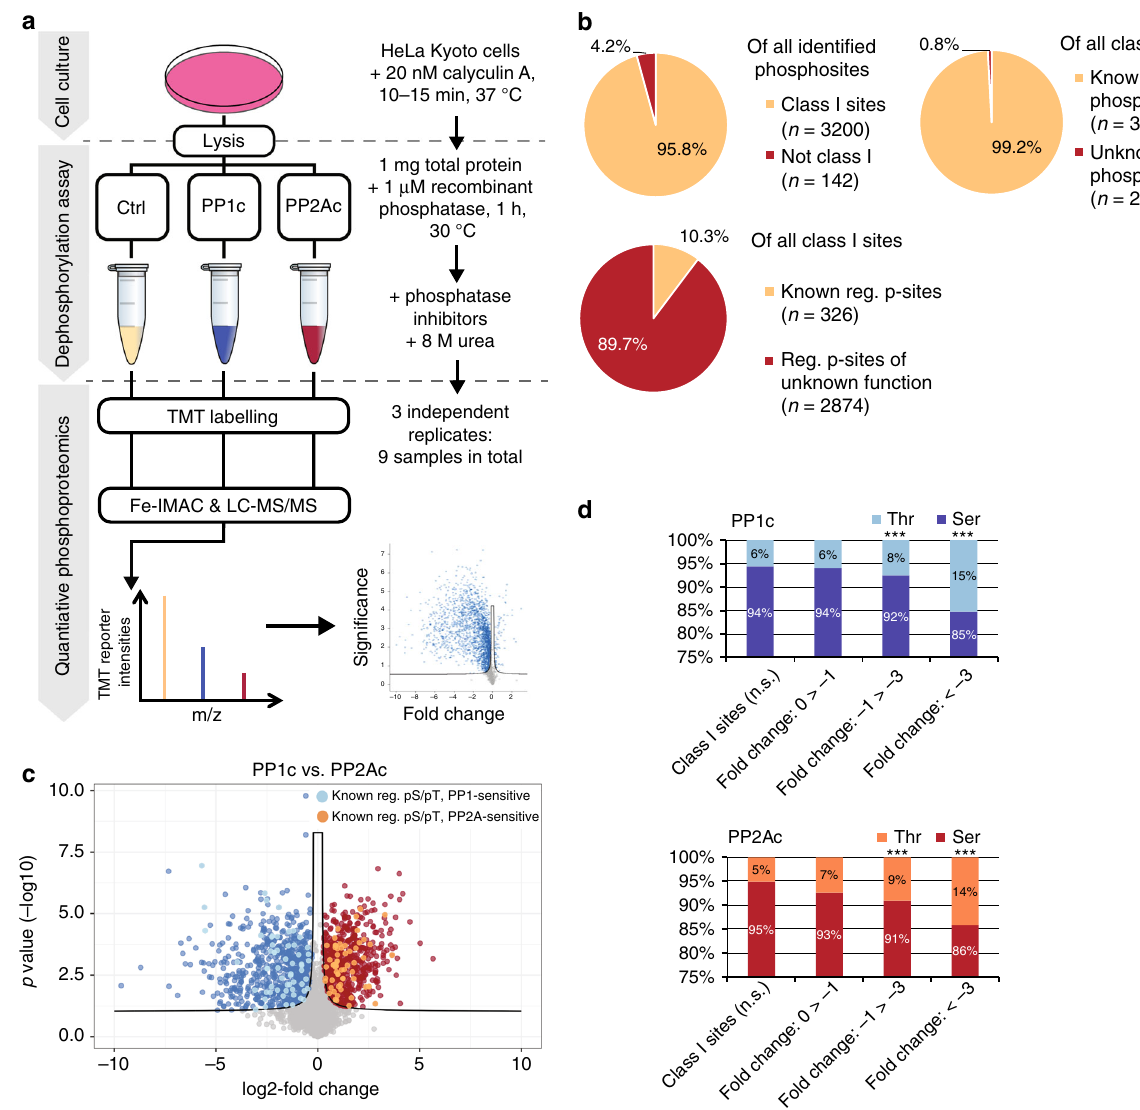
Fig. 3 Phosphoproteomics con fi rm the substrate speci fi city of PP1c and PP2Ac. a Work fl ow of phosphoproteomic experiments. b Identi fi ed p-sites were fi ltered for class I sites (localization probability of phosphorylation >0.75) and compared to known phosphosites from PhosphositePlus (v03/07/18) (Supplementary Data 2). c Differentially downregulated p-sites between PP1 and PP2A as determined by Student ’ s t test (two-sided, FDR 0.01) (see Supplementary Fig. 4b). d PP1c and PP2Ac prefer pThr over pSer. The percentage of Thr found in PP1c/PP2Ac dephosphorylated p-sites with a log2 fold-change< − 1 is signi fi cantly larger than the percentage of pThr in p-sites with a log2 fold-change > − 1 according to a two-sided Fisher ’ s exact test (***: p -value <0.001; 1.175e – 06 (PP1), 2.426e – 06 (PP2A)). n.s.: not signi fi cant. Source data of Fig. 3b, d are provided as a Source Data fi